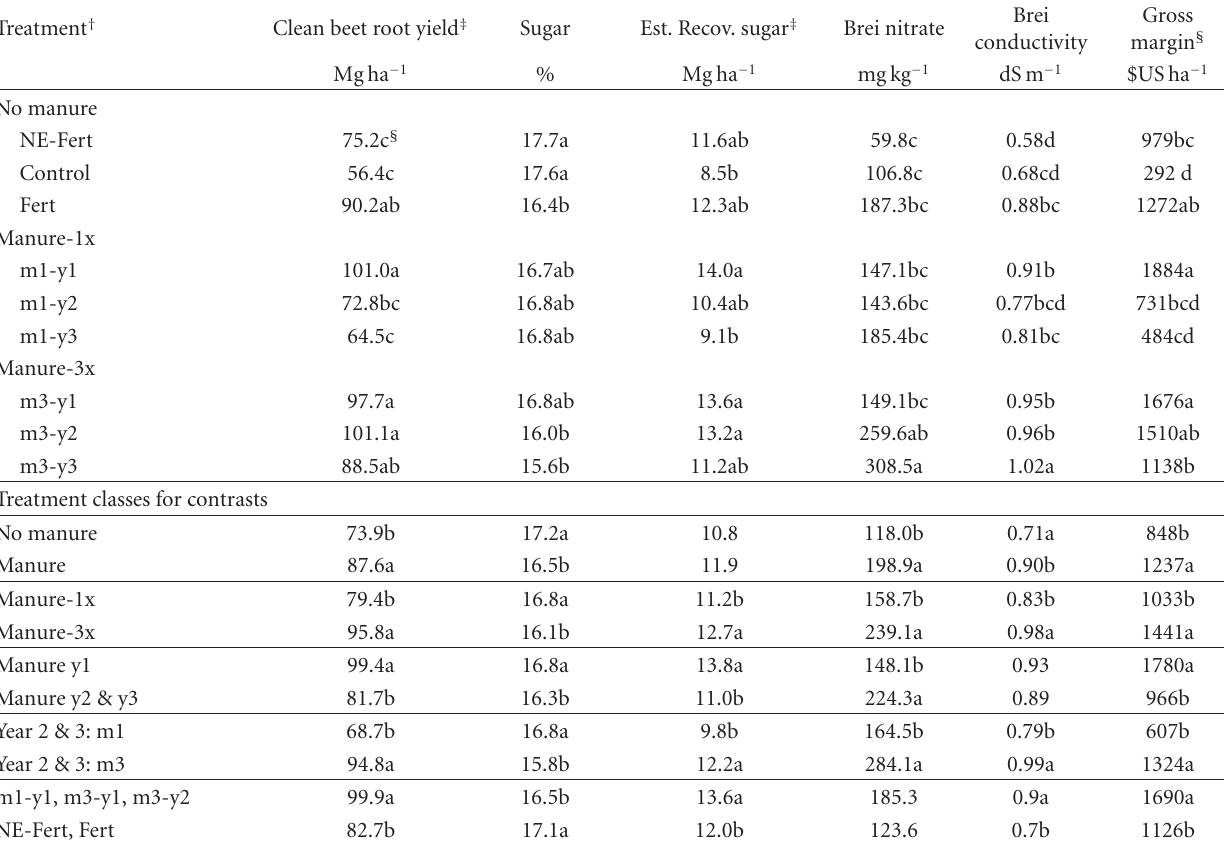
Table 5: Treatment and orthogonal contrast mean values for sugarbeet yield, quality, and gross margin parameters. Treatment